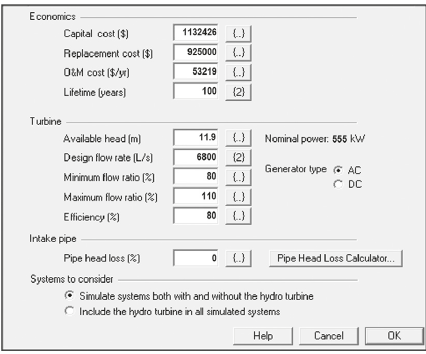
Figure 12: The specifications of the micro-hydro system in Homer.